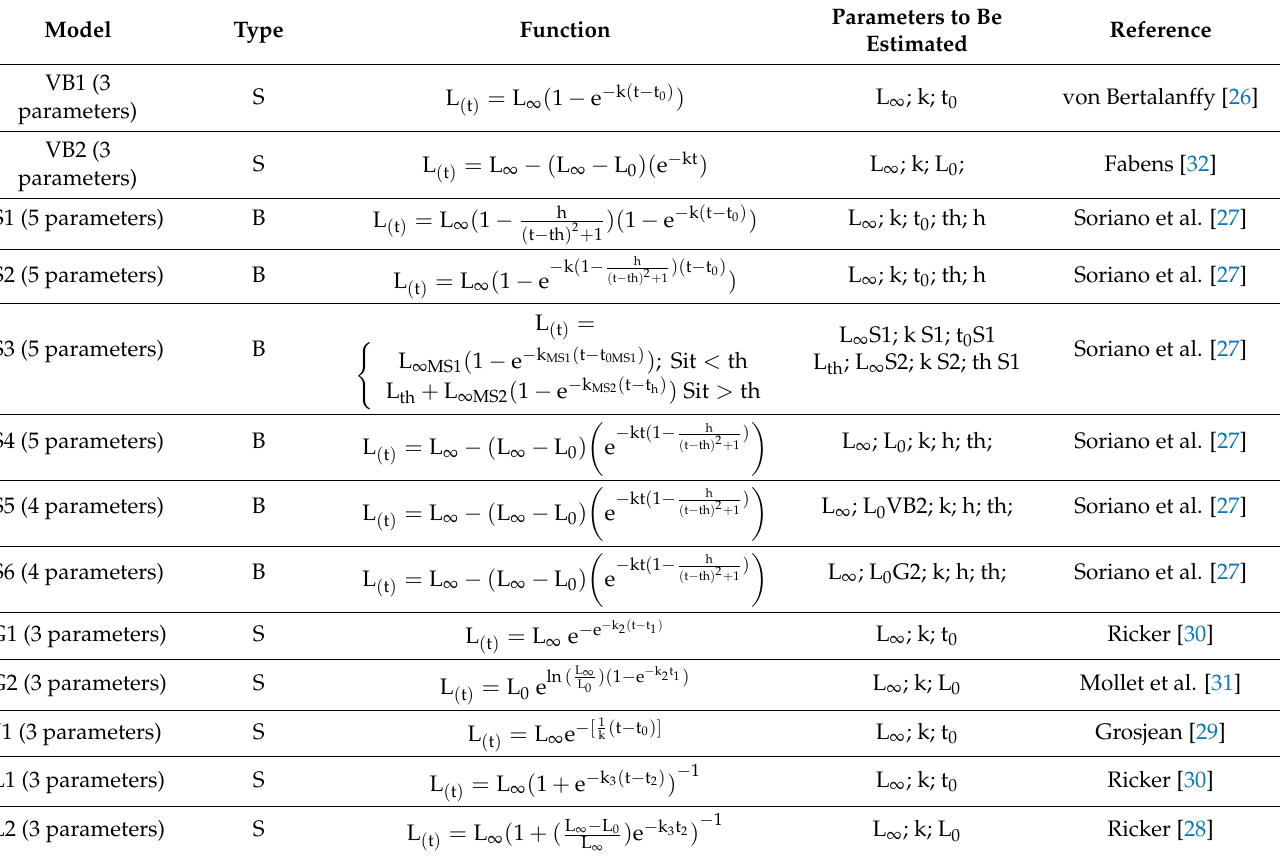
Table 1. A comparison of models describing the growth pattern of the bonnethead shark ( Sphyrna tiburo ) in the western Gulf of